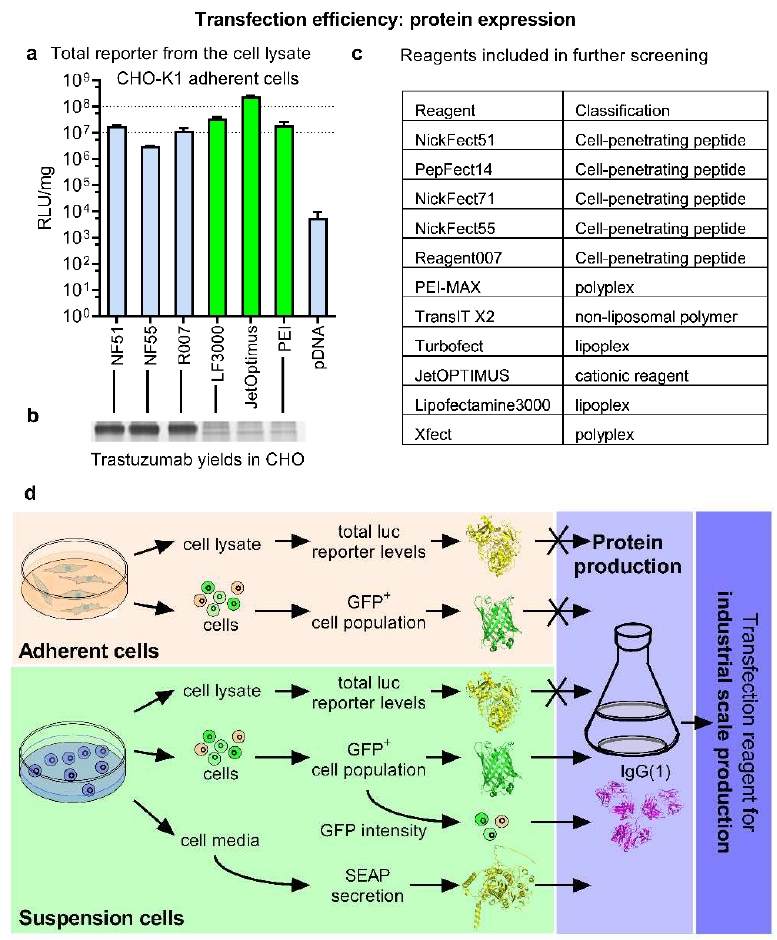
Figure 1. The total expressed reporter levels in adherent cells do not correlate with therapeutic protein production efficacy. ( a ) Transfection efficacy is assessed by quantitation of luminescence from cell lysate 24 h post-transfection of CHO-K1 adherent cells with pLuc. The top performers are highlighted in green. N = 5. ( b ) The production of Trastuzumab mAb in CHO 1H7 suspension cell culture in serum-free defined media 7 days after the transient transfection of pDNA. The complexes with PEI were formed at N/P ratio 20, and the complexes with CPPs were formed at CPP/pDNA charge ratio 2.5:1. They were assessed by SDS-PAAG 10%, with Coomassie blue staining. ( c ) List of reagents included in the further study. ( d ) A scheme depicting general workflow.